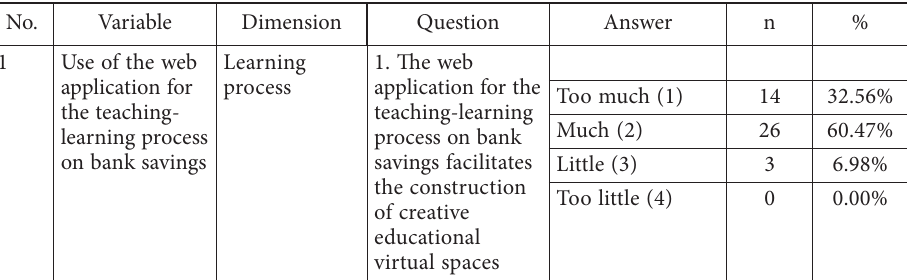
Table 2. Questionnaire about the web application for the teaching-learning process on bank savings and educational process (source: created by authors) No. Variable Dimension Question Answer 1 Use of the web application for the teaching- learning process on bank